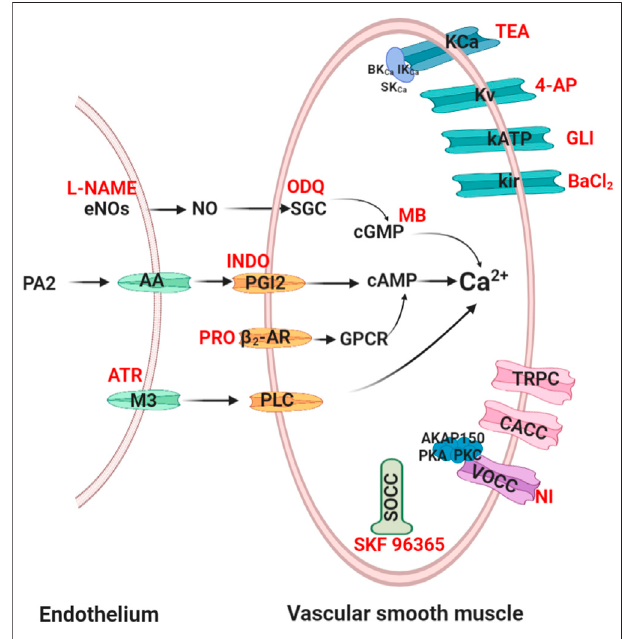
FIGURE 1 | Routes of vasodilation mechanisms. Red words denote common blockers of the corresponding pathways. eNOs, endothelial nitric oxide synthase; SGC, soluble guanylyl cyclase; cGMP, cyclic 3 ′ ,5 ′ -guanosine monophosphate; PA 2, phospholipase A 2; AA, arachidonic acid; PGI2, prostaglandin 2; cAMP, cyclic adenosine 3 ′ , 5 ′ -monophosphate; β 2-AR, β 2- adrenoreceptor; PLC, phospholipase C; L-NAME, nitro-L-arginine; ODQ, 1H- [1, 2, 4] oxadiazolo [4, 3- α ] quinoxalin-1-one; MB, methylene blue; INDO, indomethacin; PRO, propranolol; ATR, atropine; NI, nifedipine; GLI, glibenclamide; 4-AP, 4-aminopyridine; TEA,